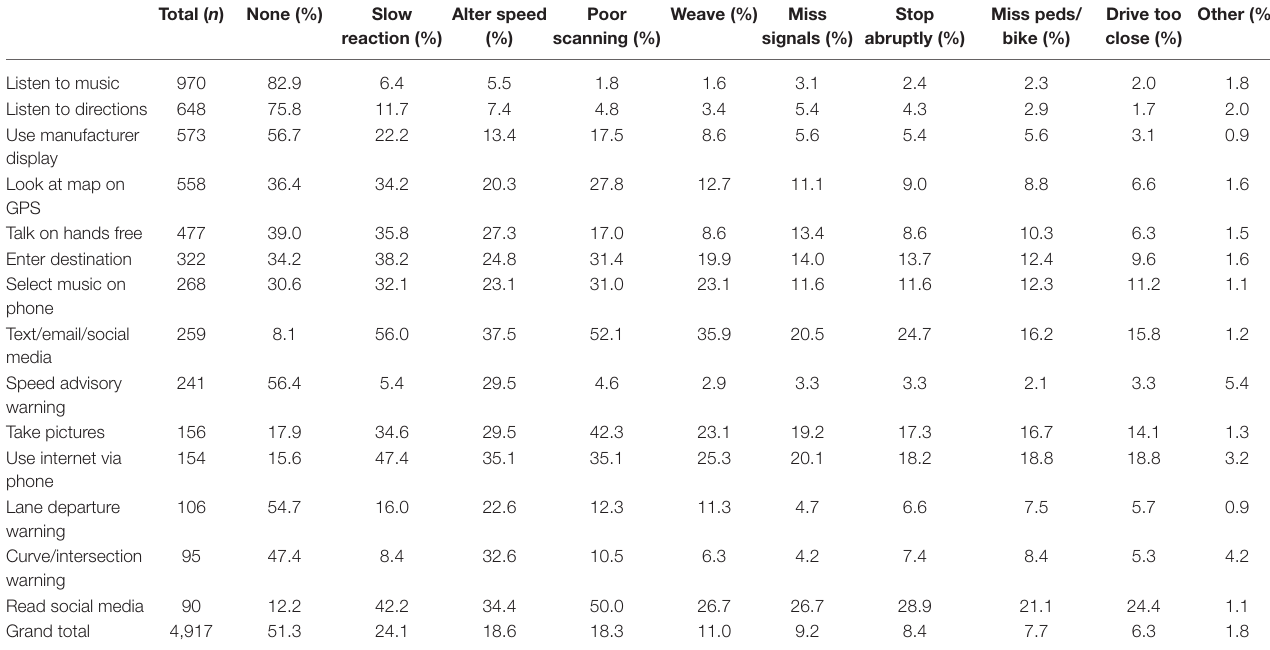
TABLE 5 | The effects of engaging in each IVIS behavior or